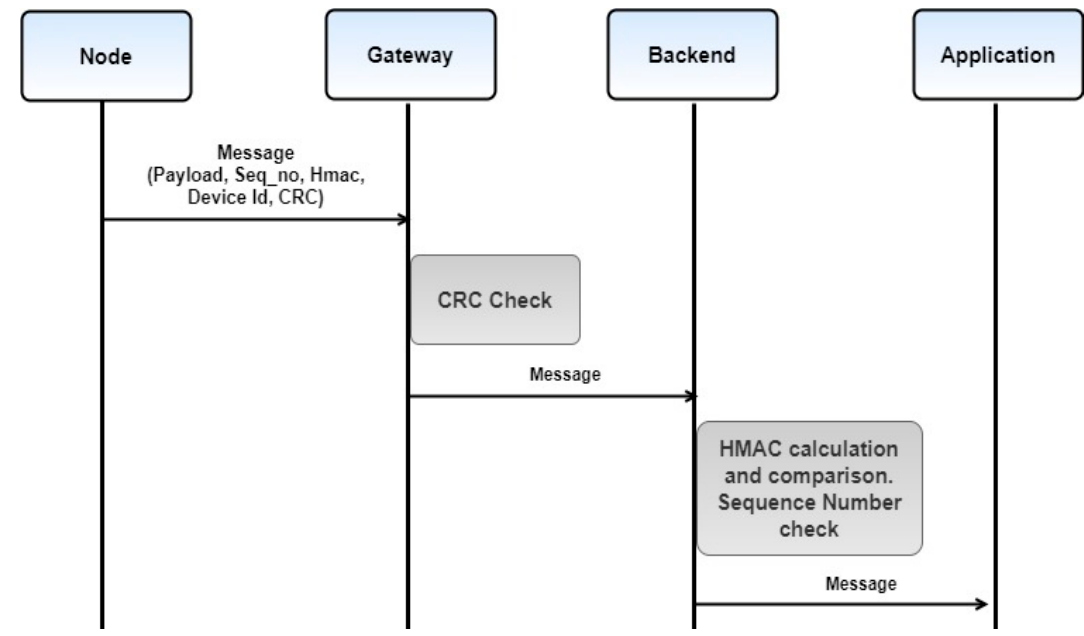
Figure 1. Sigfox message transmission process.